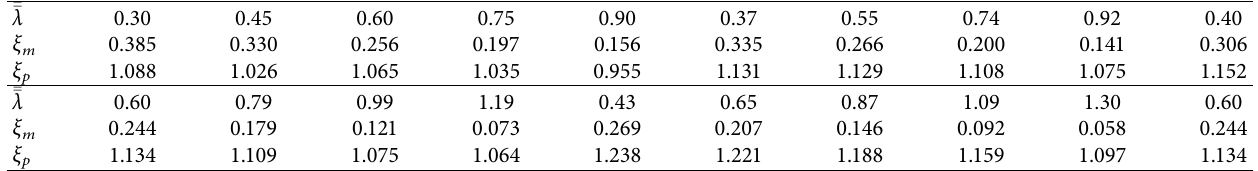
Table 5: ξ p , ξ M as the form parameters fitting